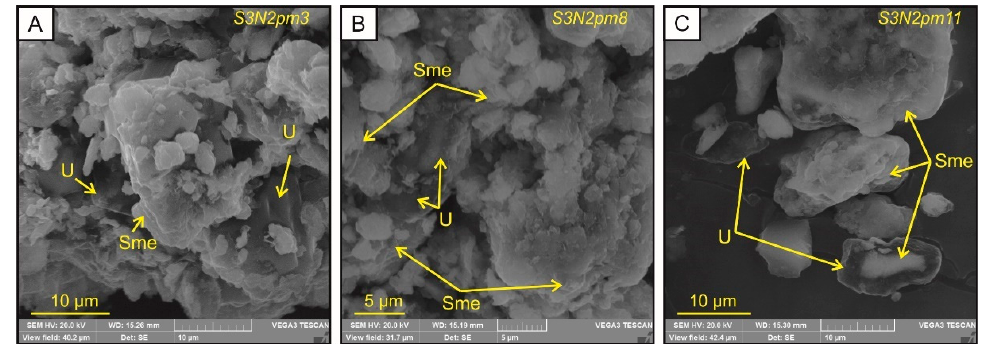
Figure 2. SEM images of composites S3N2pm3 ( A ), S3N2pm8 ( B ), and S3N2pm11 ( C ). Note the thicker urea coating in S3N2pm11 compared to other composites. U—urea particles, Sme—smectite (montmorillonite) relics.